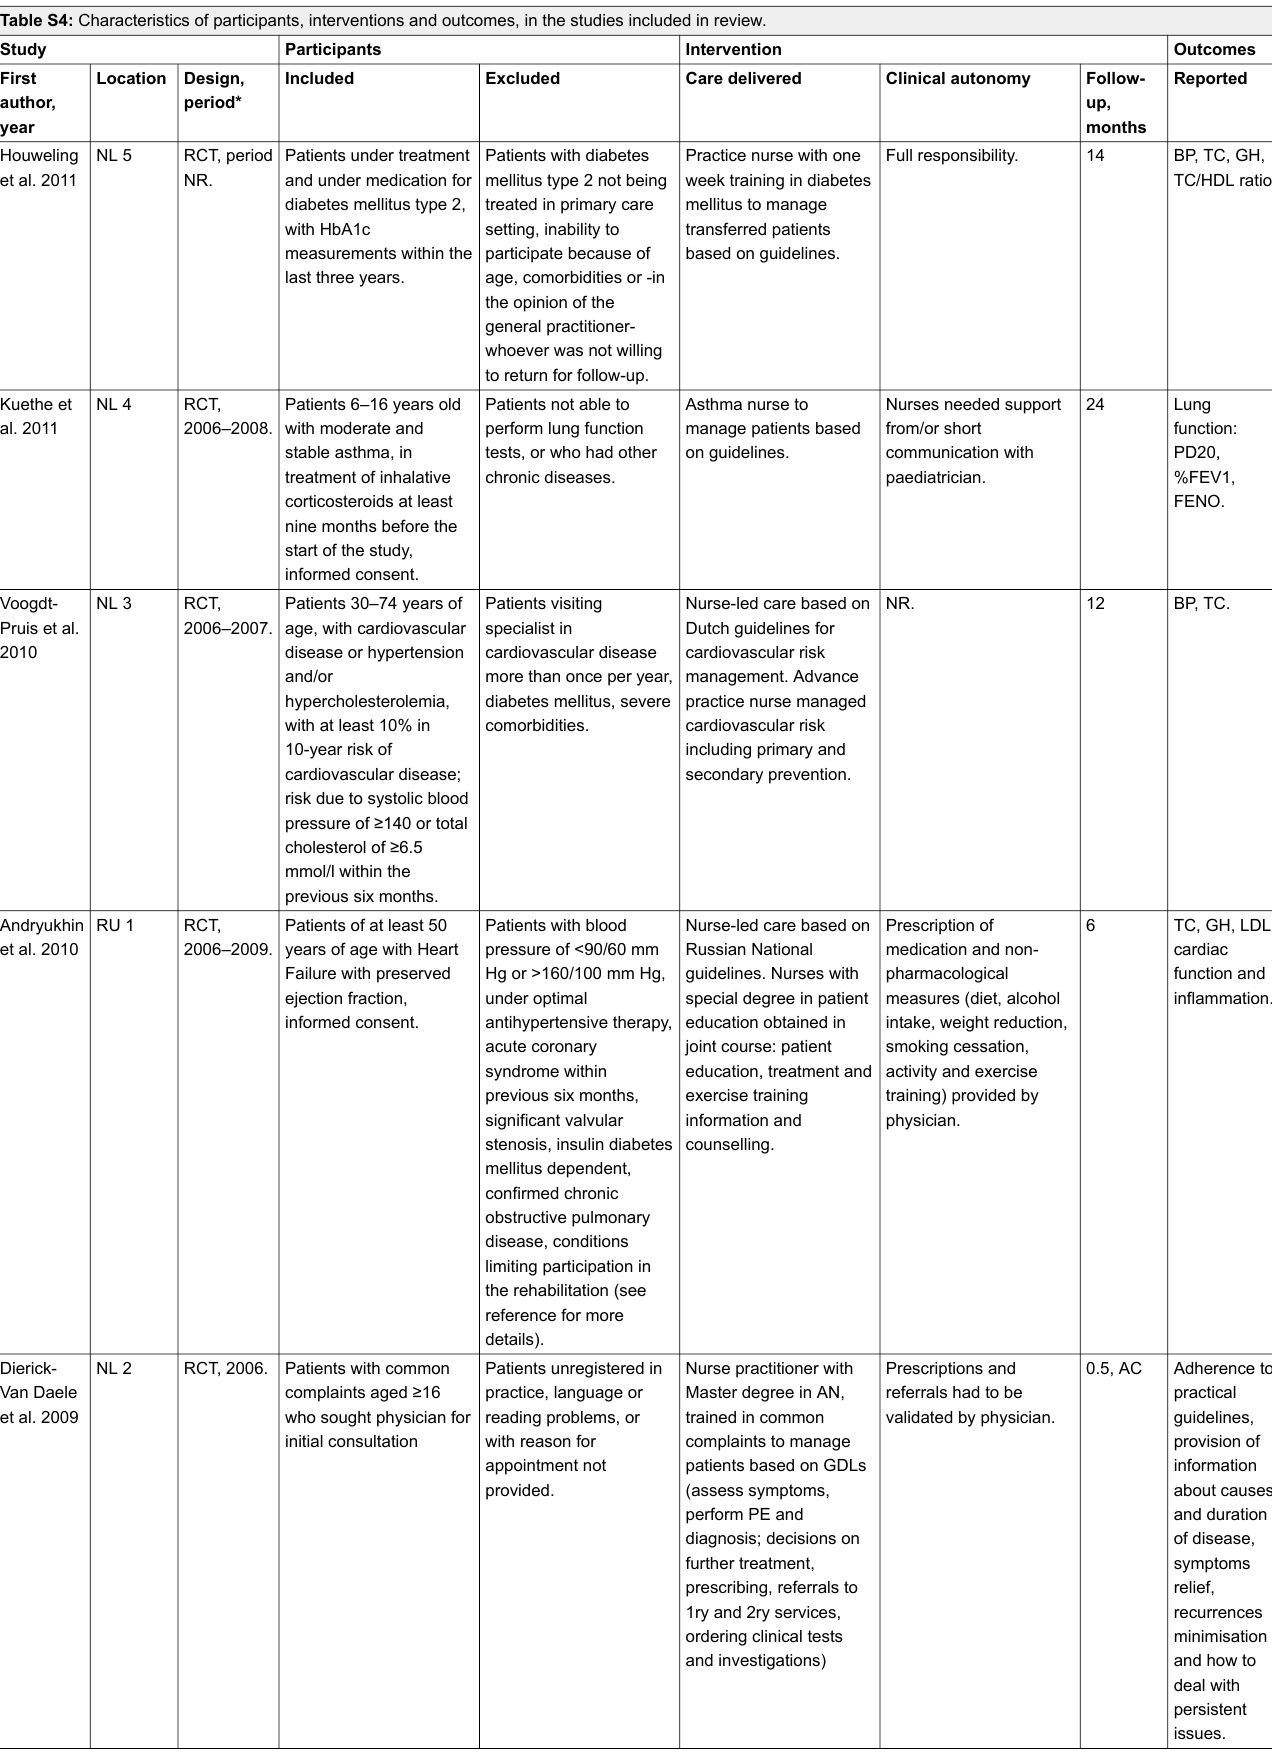
Table S4: Characteristics of participants, interventions and outcomes, in the studies included in